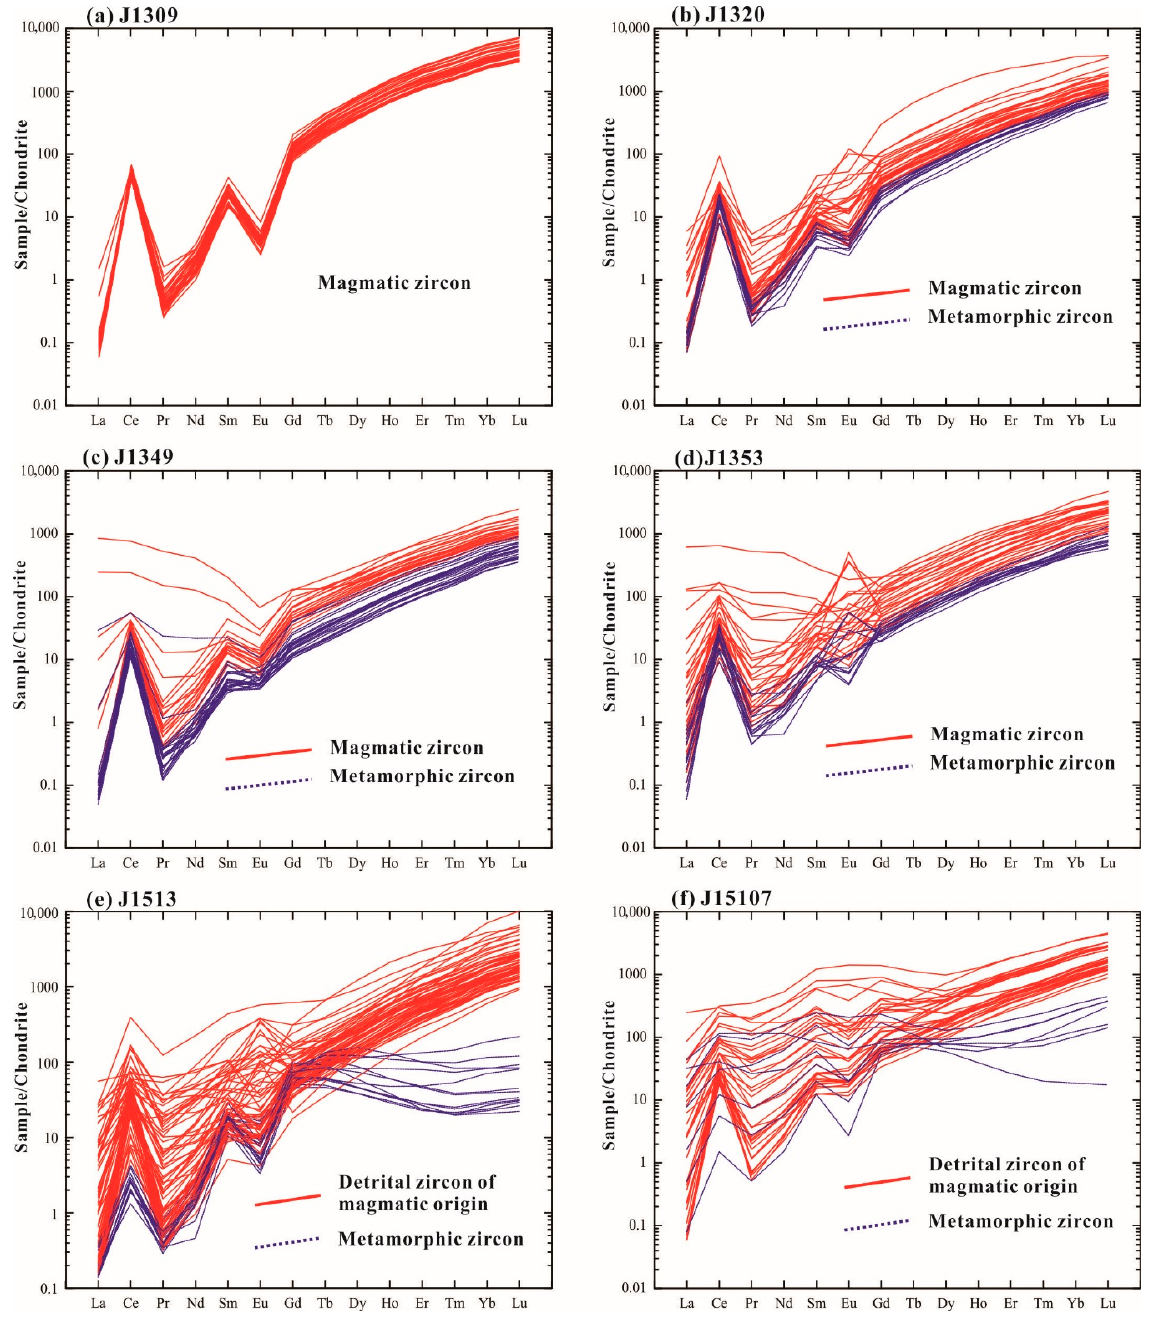
Figure 7. Chondrite-normalized REE patterns [44] for zircons of magmatic (solid red lines) and metamorphic origin (dashed blue lines) for analyzed samples from Eastern Hebei. The values of chondrite are from [60]. ( a ) J1309 syenogranite; ( b – d ) J1320, J1349, J1353 orthogneisses; ( e , f ) J1513, J15107 felsic